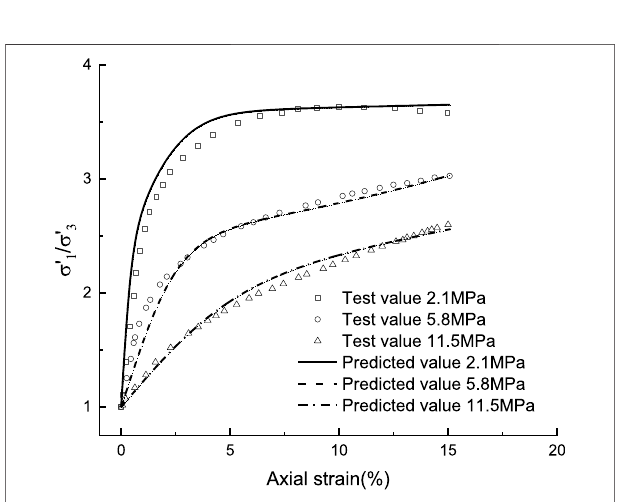
FIGURE 8 | The change of undrained shear stress ratio of dense sandy soil under different initial con fi ning pressures.